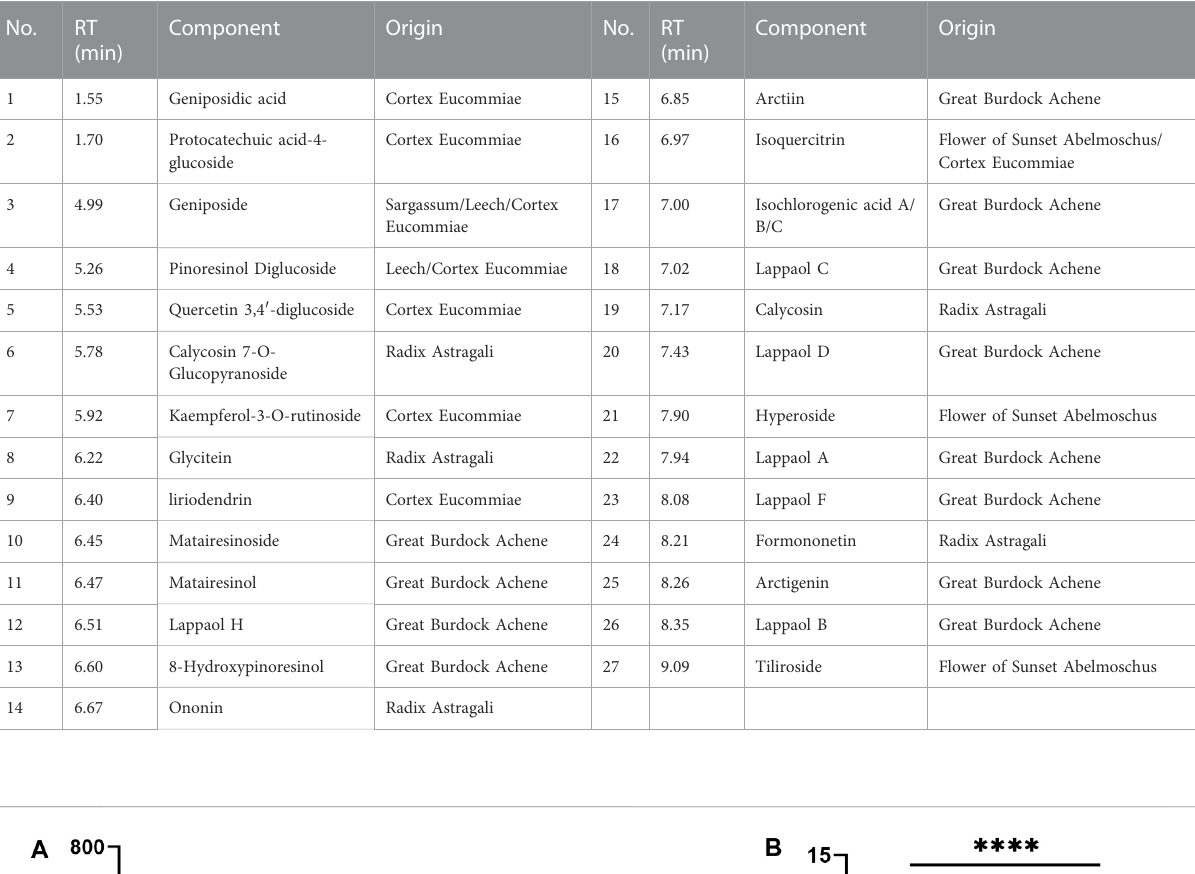
TABLE 2 Identi fi cation of 27 components of QRXZYQF freeze-dried powder using Vanquish UHPLC ™ . No.